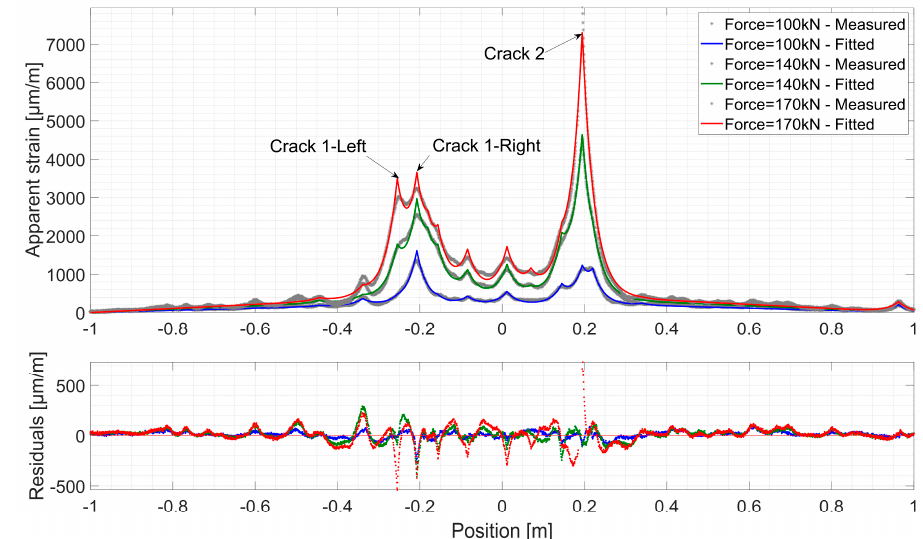
Figure 15. Comparison between the measured and fitted strain profiles and the corresponding residuals over Line 3 of Thorlabs cable.